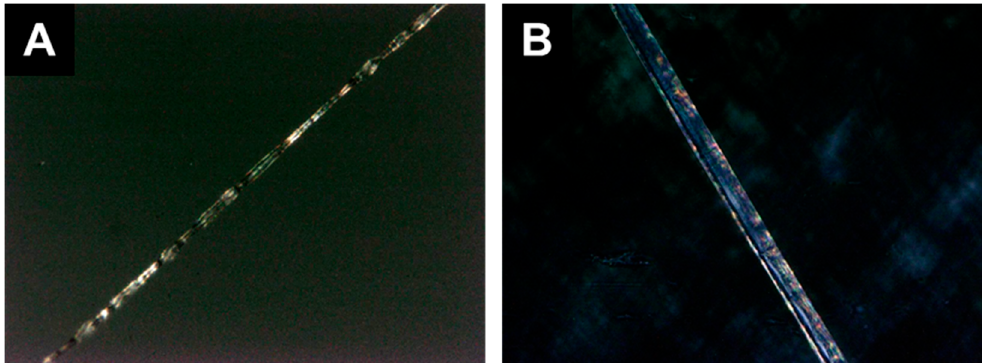
Figure 7. Polarized light microscopy of ( A ) 20 wt.% PS and ( B ) 20 wt.% PS with 20 wt.% LC-2 fibers at 25 °C. Portions of the fiber containing LC-2 appear blue which are not apparent in the PS only fiber indicating the successful incorporation of the liquid crystal. However, no color change was observed upon heating to 50 °C.